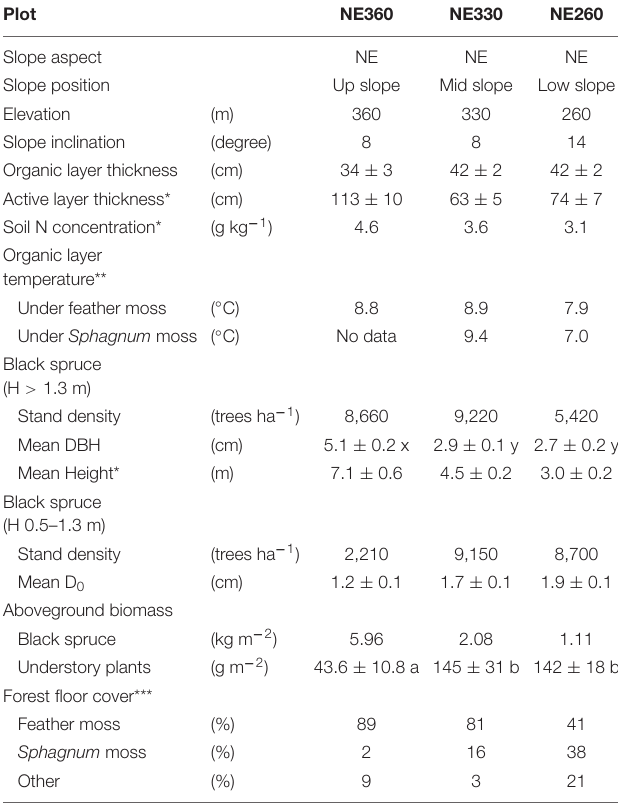
TABLE 1 | Stand characteristics of the black spruce stands in this study.